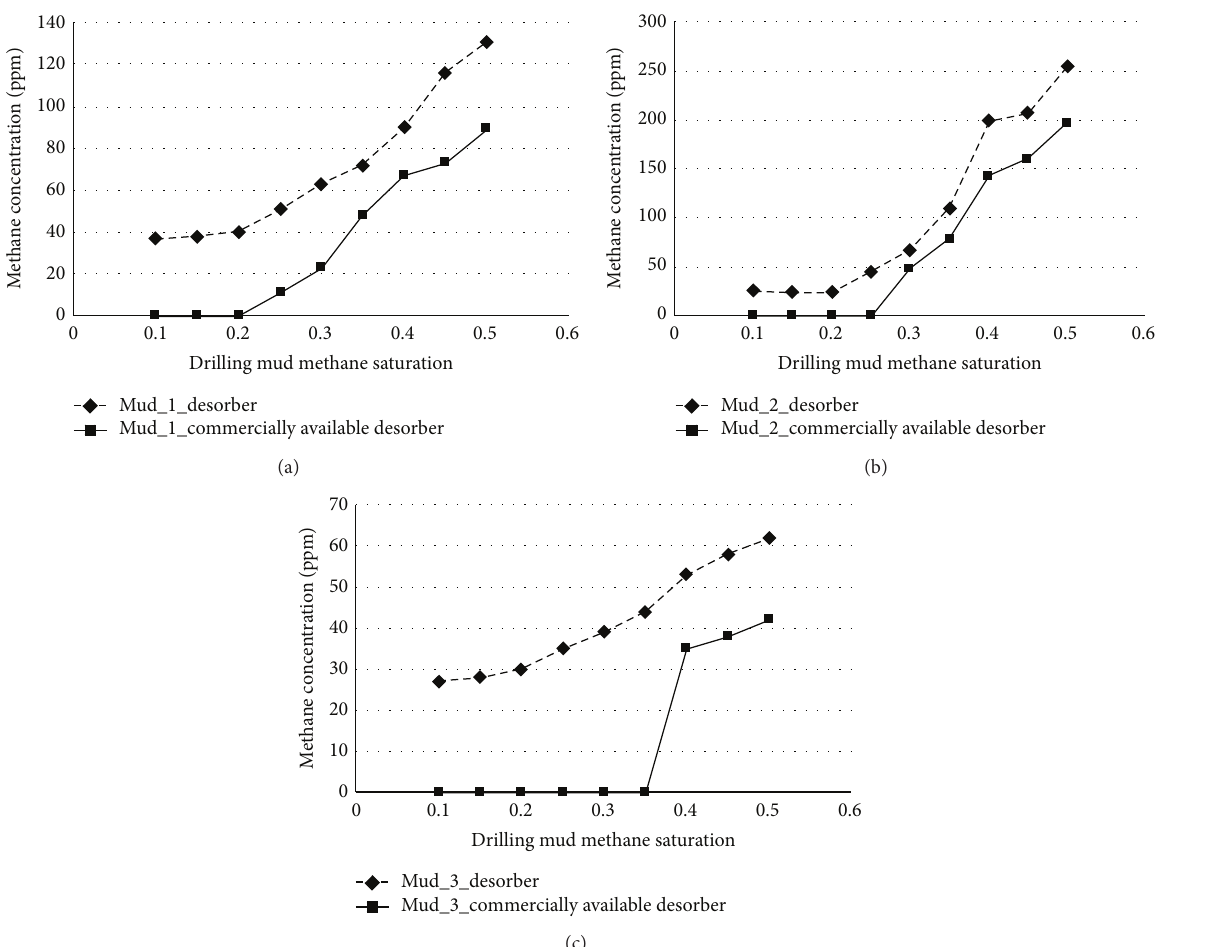
Figure 9: The measured concentration of methane in the function of drilling mud methane saturation for novel and commercially available desorbers. The results for (a) heavy drilling mud from Daszewo borehole (density 2.06 kg dm −3 ), (b) medium density drilling mud from Bro´nsko borehole (density 1.67kg dm −3 ), and (c) light drilling mud from Daszewo borehole (density 1.18kg dm −3